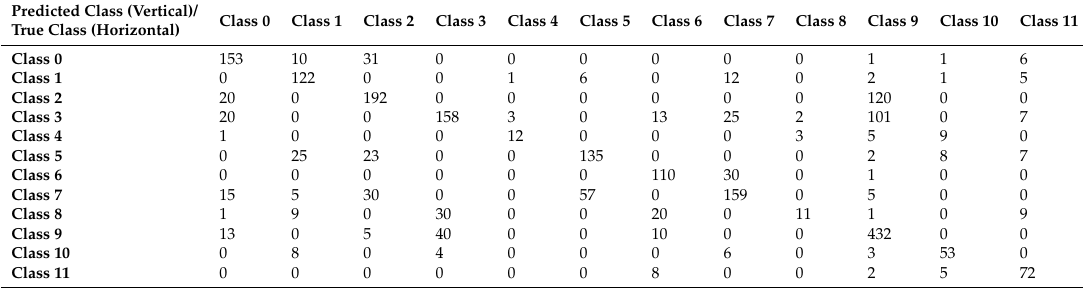
Table 8. Confusion matrix